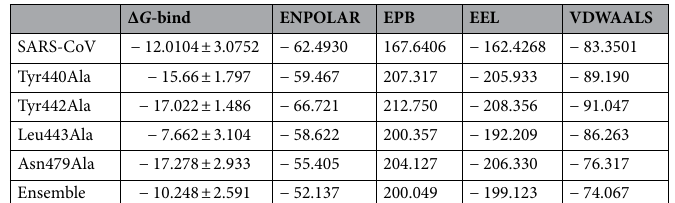
Table 4. The MM-PBSA binding energies (kcal·mol −1 ) for selected alanine scanning in residue Tyr440, Tyr442, Leu443, and Asn479 for SARS-CoV.